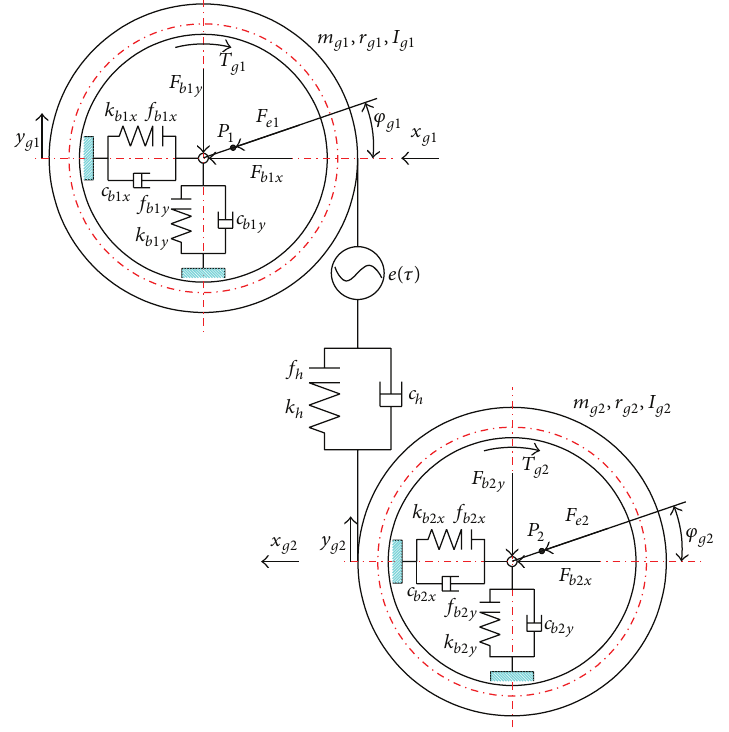
Figure 2: Dynamic model of gear